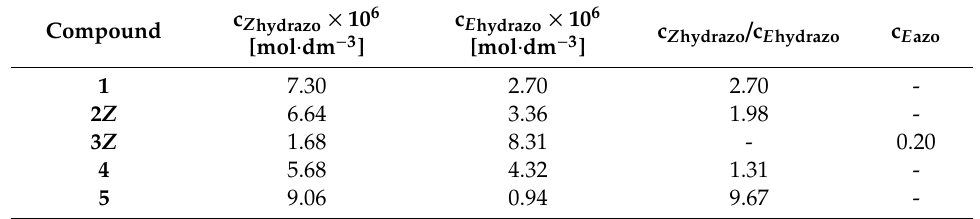
Table 1. The concentration of Z -isomers ( c z hydrazo ), E -isomers ( c E hydrazo ), and ( c E azo ) of studied